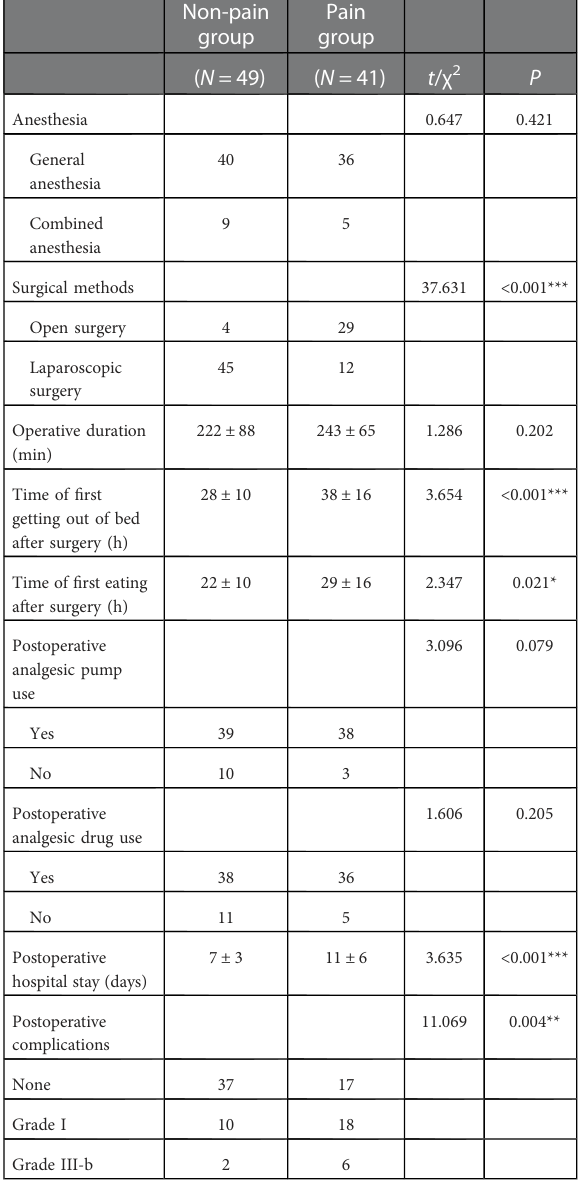
TABLE 8 Perioperative conditions of the two groups were